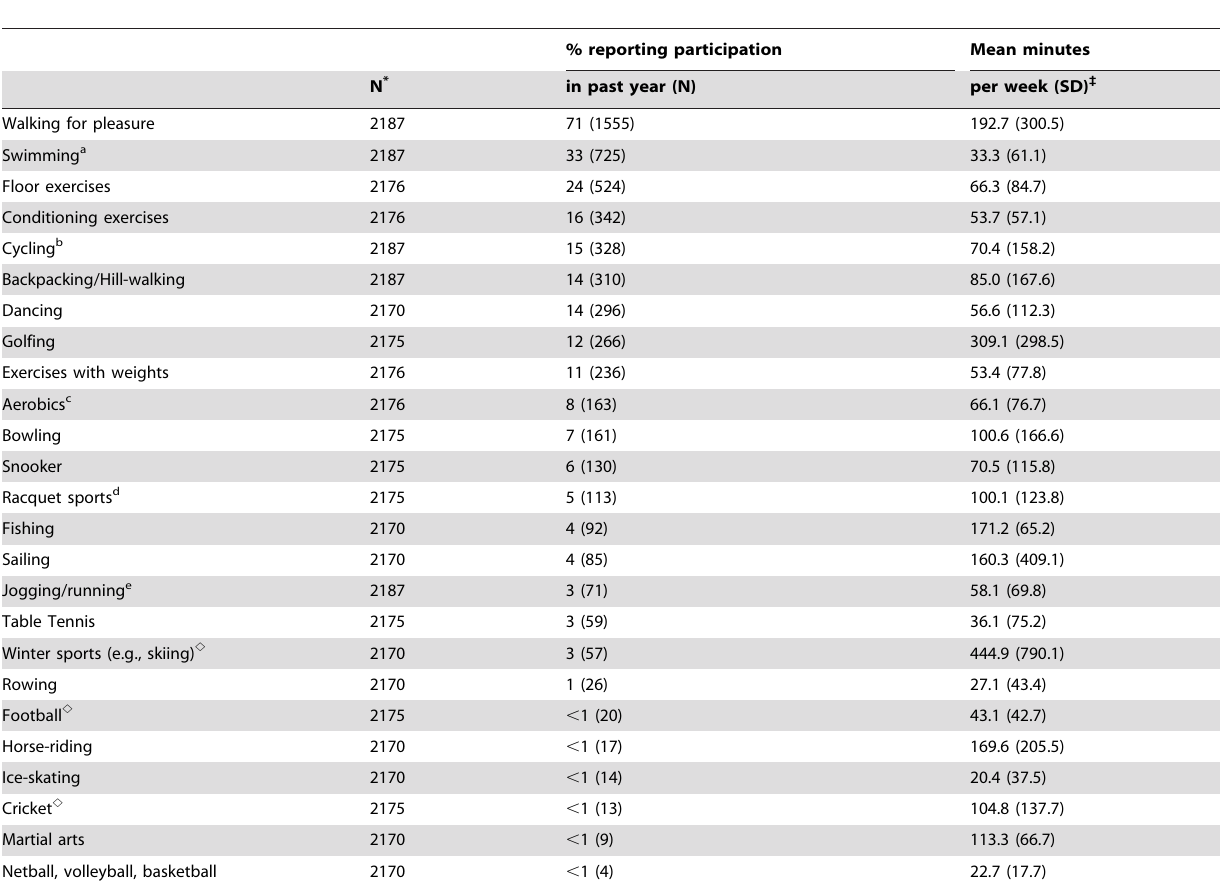
Table 1. The percentage (%) of participants reporting each sport and exercise activity in the past year and mean (SD) time (minutes per week) spent in each